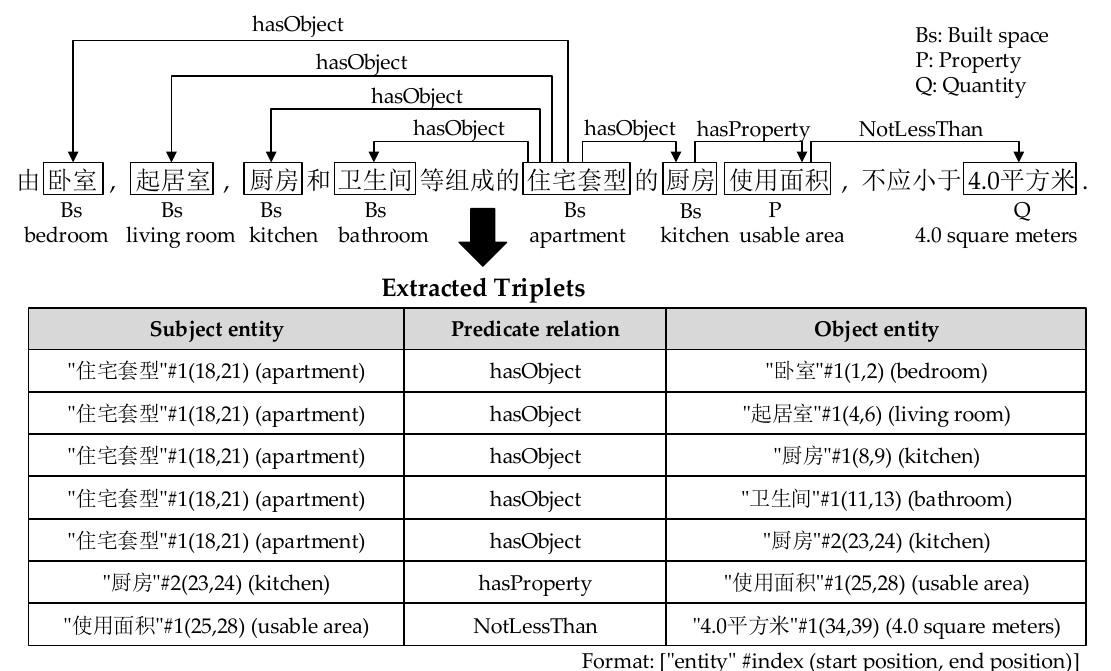
Figure 1. Example illustrating multiple triplets in a